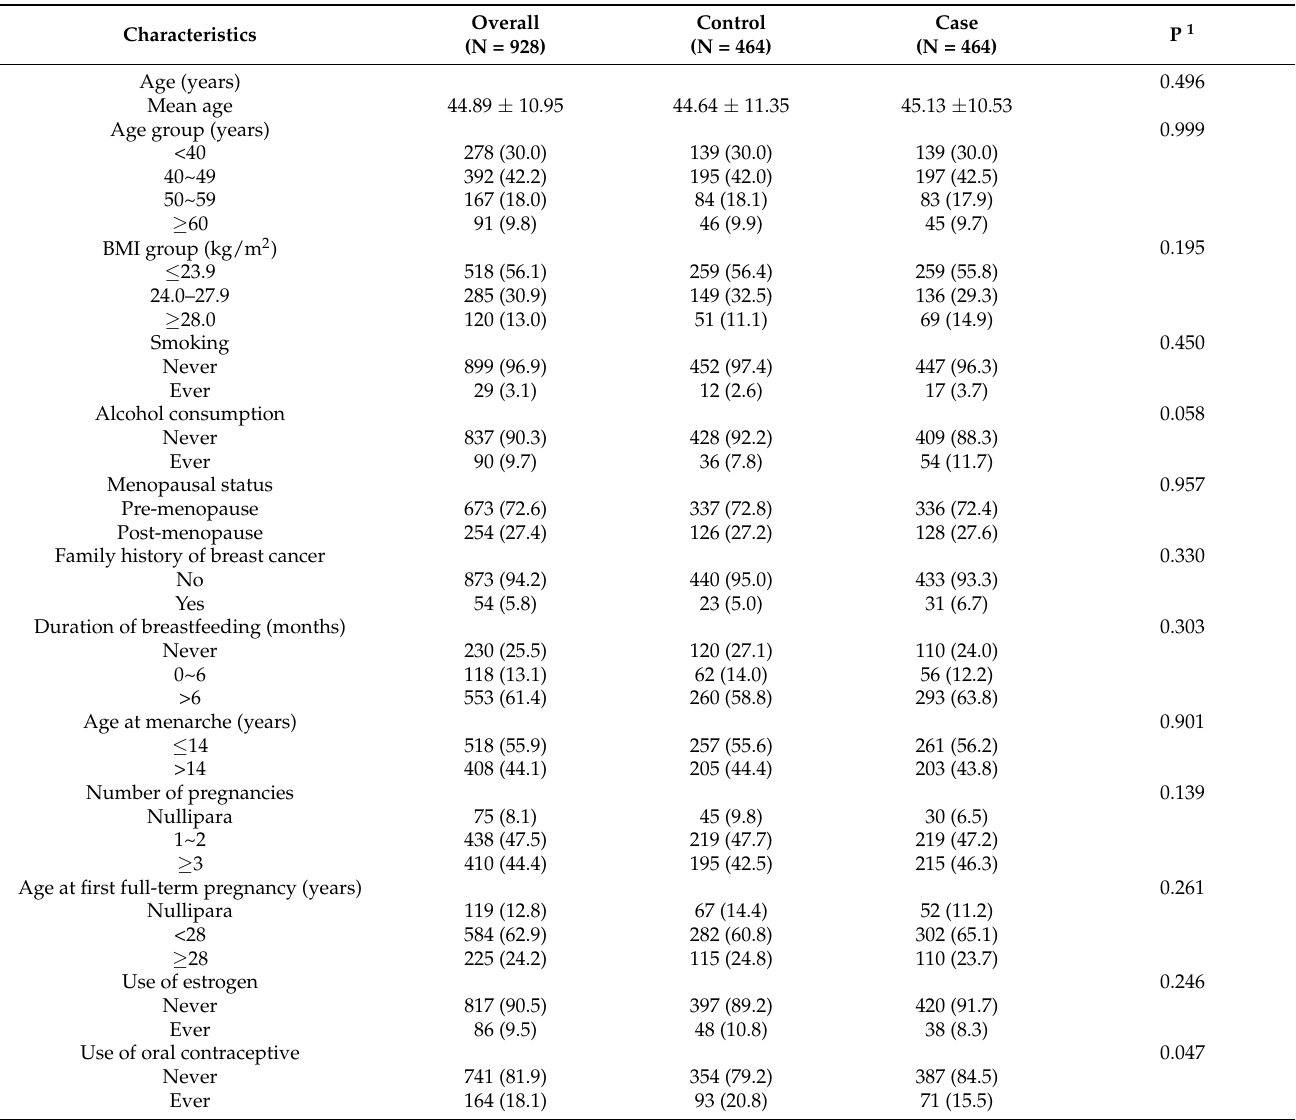
Table 1. Basic characteristics of study